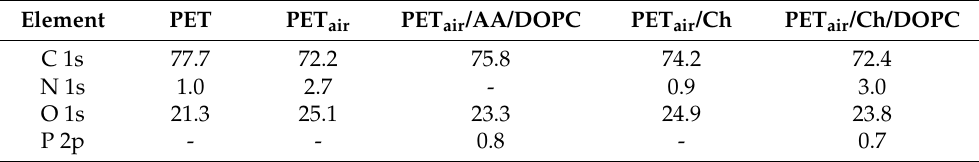
Table 2. XPS data for unmodified and modified PET surfaces (conc. in at.%). Element PET PET air PET air /AA/DOPC PET air